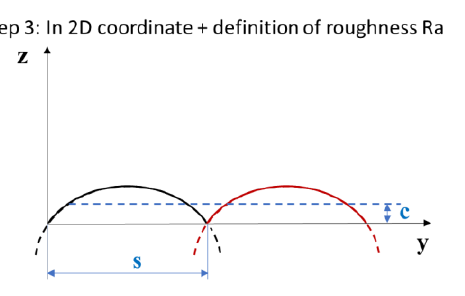
Figure 2. Steps to derive the analytical expression of surface roughness Ra. ℎ denotes the cap height, 𝑑 denotes the re-melted depth, 𝑊 represents the molten pool width, and 𝑠 is the hatch space. 𝑘 represents the intersection height of adjacent melting tracks as measured from the base of the cap area. 𝑐 represents the height of mean line of the surface profile. 𝑦, 𝑧 represent the transverse direction and build direction, respectively.